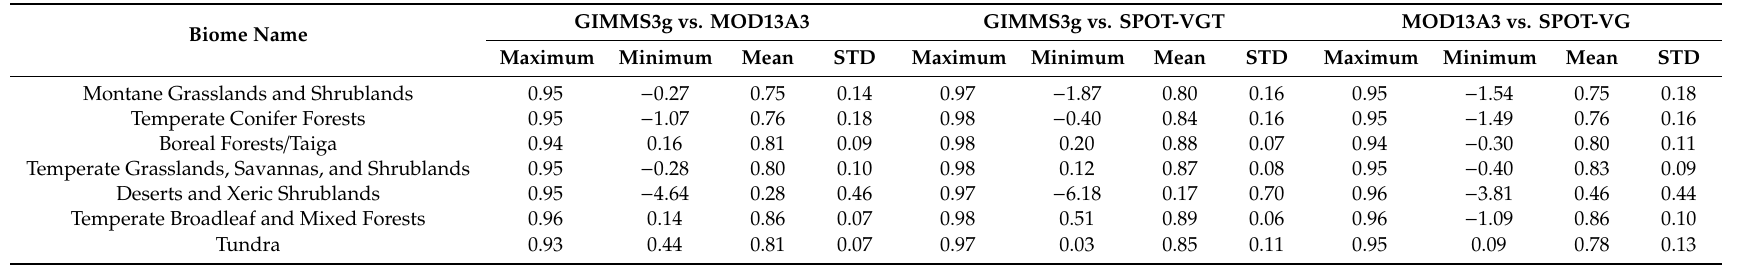
Table 3. Zonal statistic results of the AC values between the three NDVI products over the seven biomes of the MP.